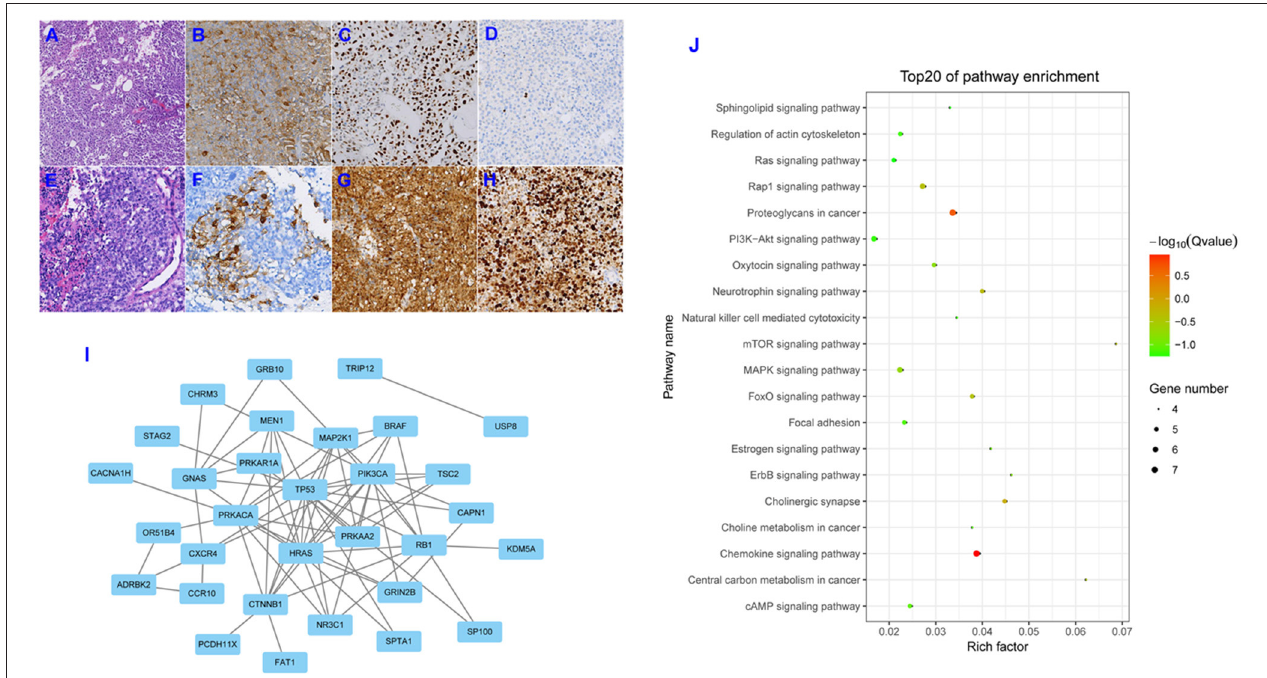
FIGURE 2 | Hematoxylin and eosin (H&E) staining showed circular cells with uniform morphology and no heterotypic cells for the first operation specimen ( A ; original magnification, × 200). Immunohistochemical (IHC) staining revealed positive expression for ACTH and P-53 ( B,C ; original magnification, × 200), and Ki-67 expression was essentially negative ( D ; original magnification, × 200). H&E staining revealed excessive pleomorphic cells and frequent mitoses ( E ; original magnification, × 200). IHC staining was positive for the expression of ACTH ( F ; original magnification, × 200), and strongly positive staining for P53 and Ki-67 was observed ( G,H ; original magnification, × 200). Depiction of the protein-protein interaction (PPI) network for the 44 mutant genes involved in pituitary adenomas (I) . Depiction of the Kyoto Encyclopedia of Genes and Genomes (KEGG) pathways enriched for the 44 mutant genes (J)